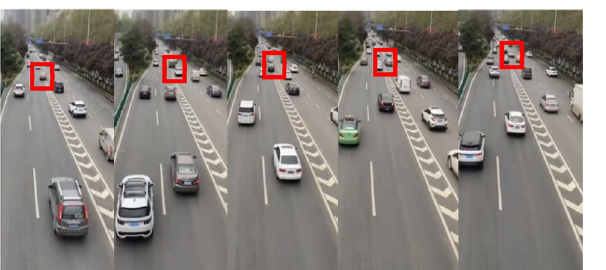
Figure 11. In the interaction scenes collected from the real road data set, the area where the game takes place is marked with the red